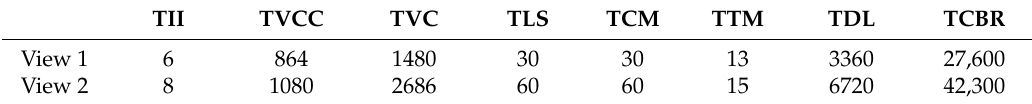
Table 1. Operand of Tasks. TII, Task of Interactive Input; TVCC, Task of Visual Condition Calculation;